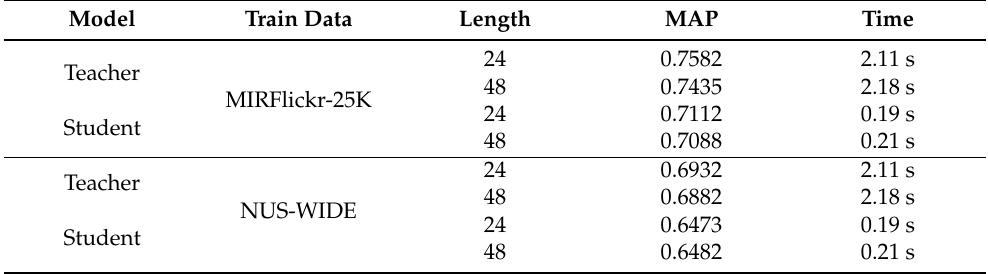
Table 1. Transformer-based teacher model and fast student model comparison. Length is the size of hash codes. Time indicates the time for the model to generate the hash codes on the query image. Model Train